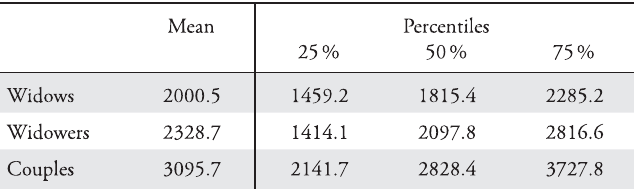
Table 5: Expenditures by Household Type Mean Percentiles 25% 50% 75% Widows 2000.5 1459.2 Couples 3095.7 3727.8